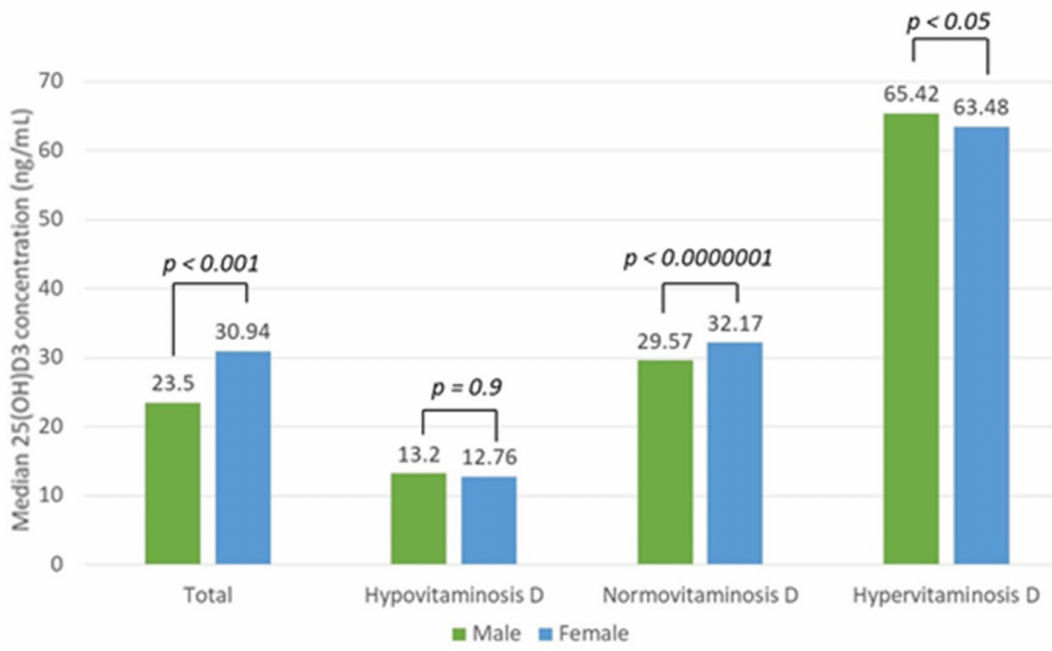
Figure 6. Median vitamin D (25(OH)D3) concentration difference between sexes in the total patient and hypo-, normo-, and hypervitaminosis D groups with the reference values of 20–50